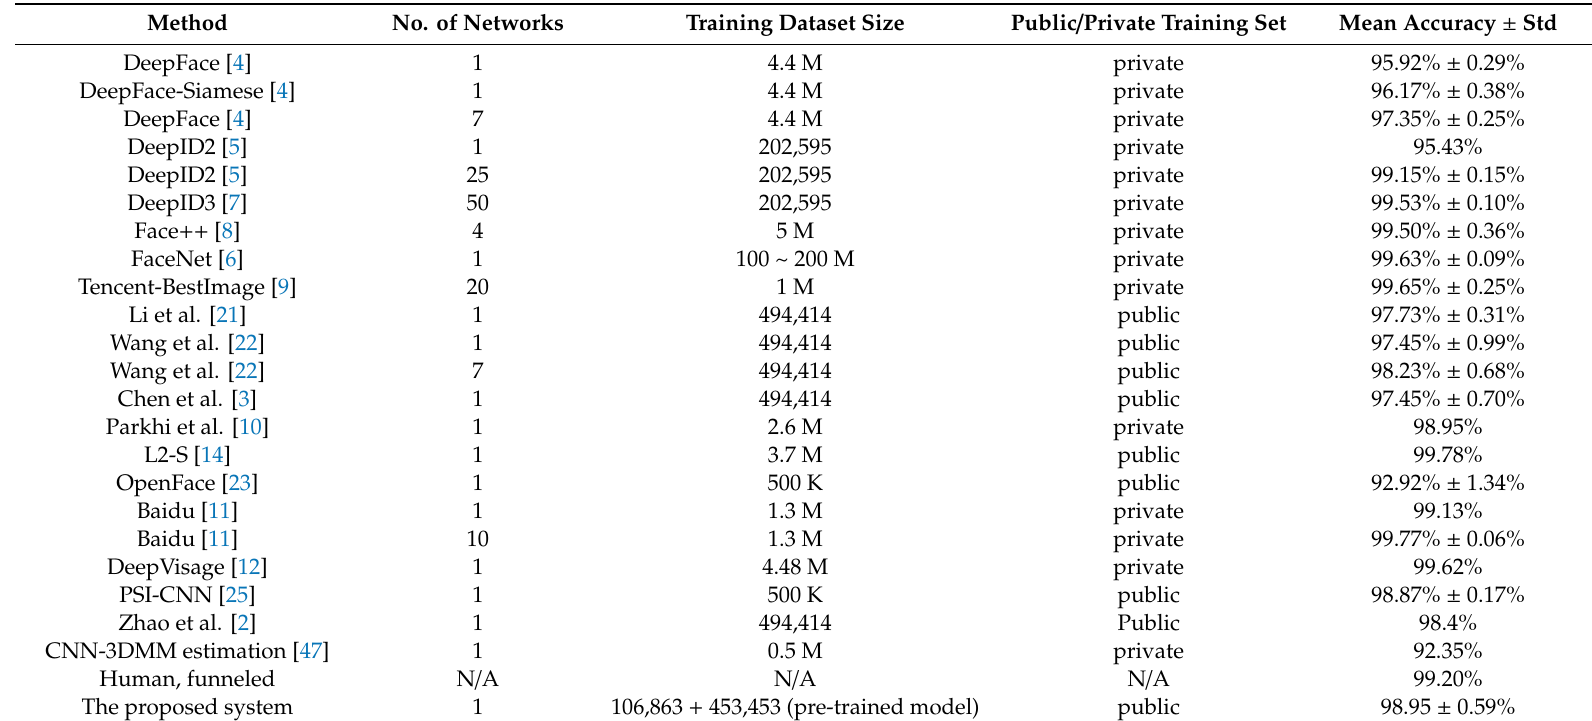
Table 1. Verification accuracies of di ff erent methodologies on LFW